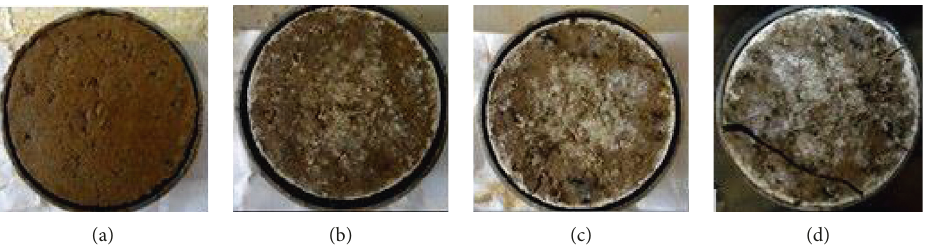
Figure 6: Photos of cracks on natural expansive soil samples with different numbers of drying-wetting cycles. (a) 1 cycle. (b) 5 cycles. (c) 8 cycles. (d) 9